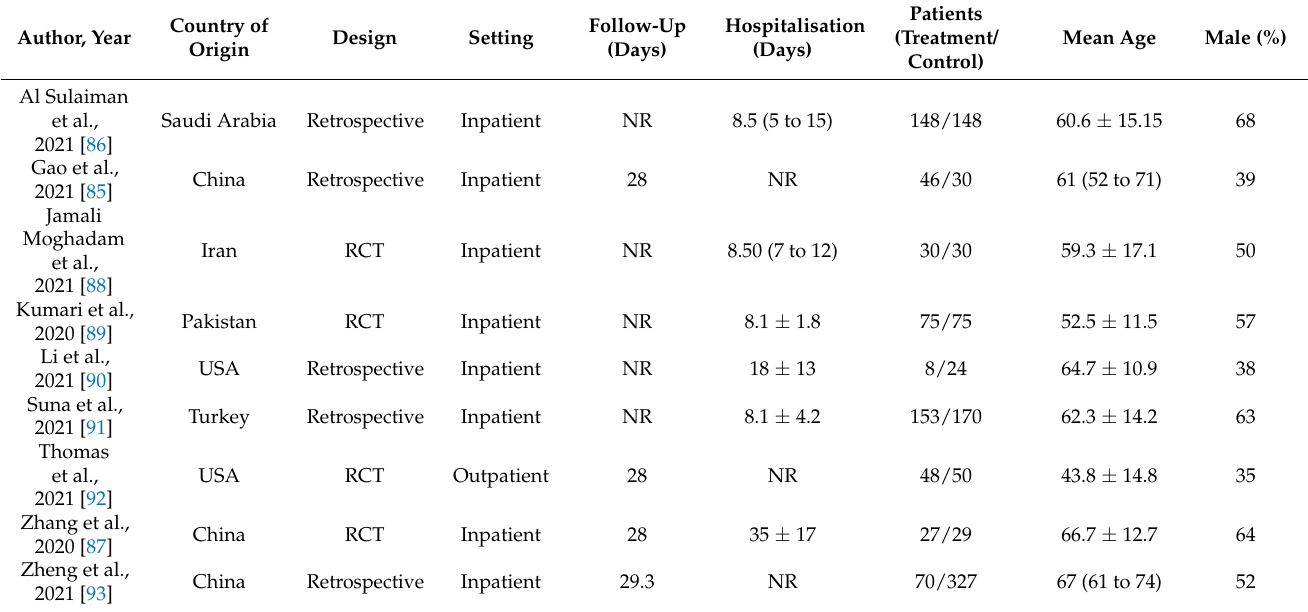
Table 2. Studies which investigated Vit C implementation in COVID.